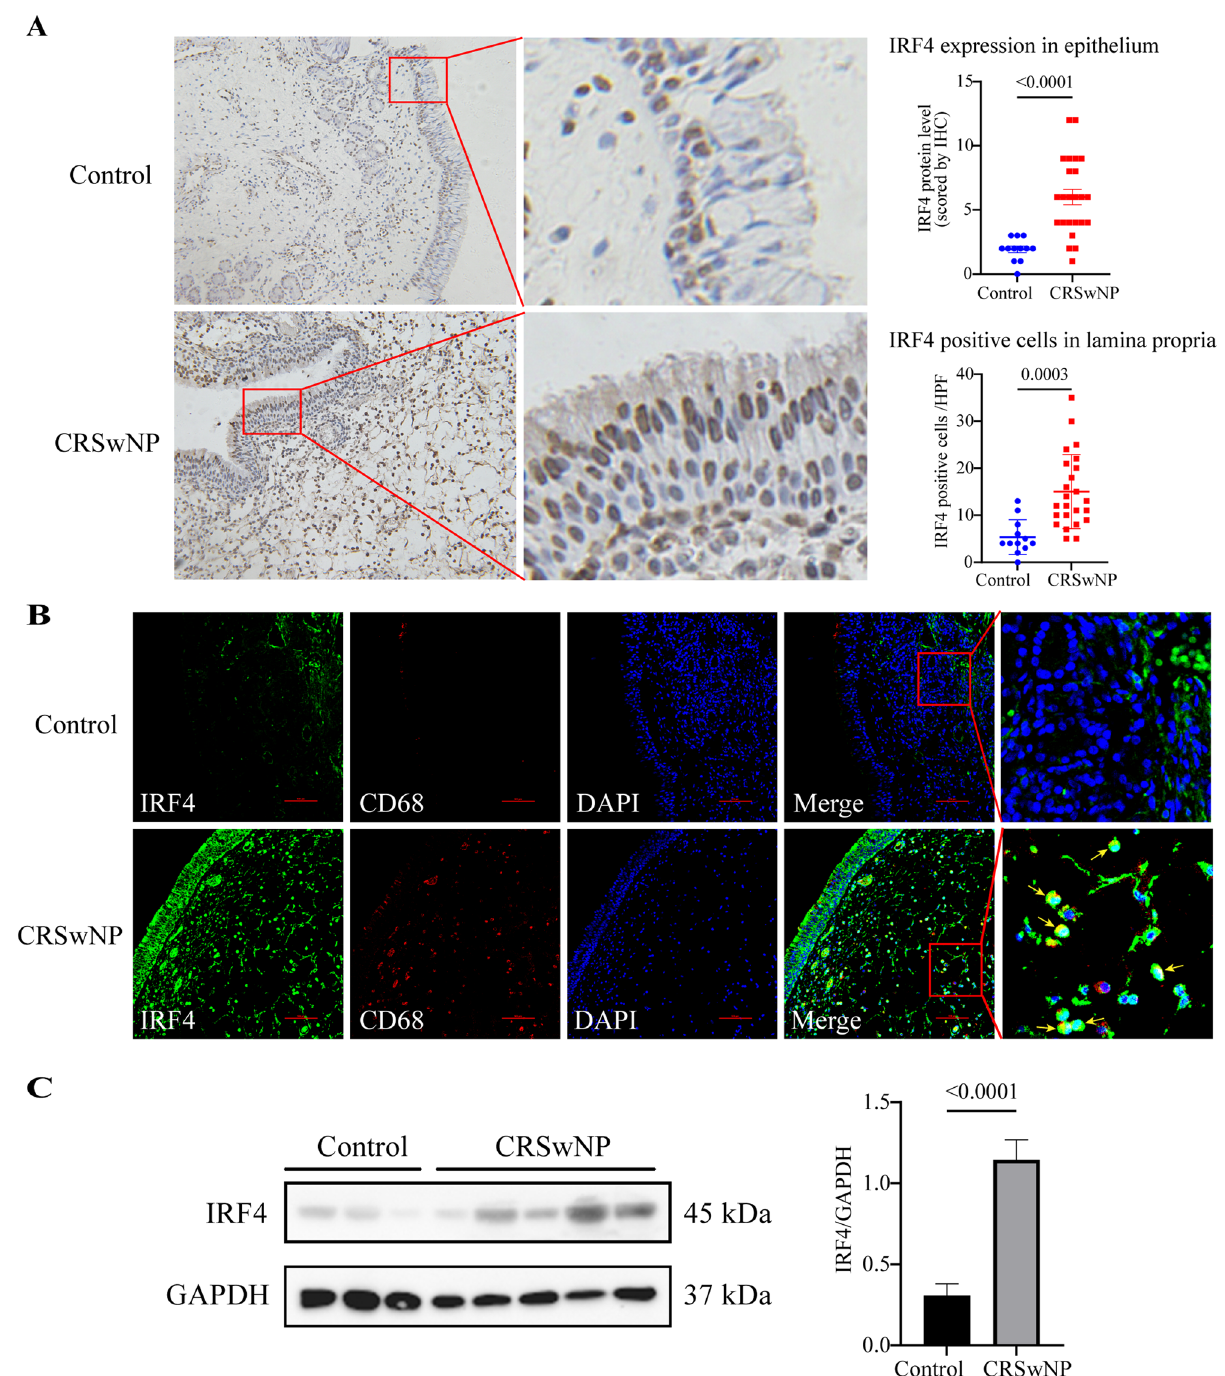
Figure 9. Experimental validation of the protein expression levels of IRF4. ( A ) Immunohistochemistry study demonstrated increased expression of IRF4 in the cytoplasm and nucleus, in nasal epithelial cells and inflammatory cells in lamina propria in nasal polyps. The representative photomicrographs are shown (original magnification × 200). ( B ) Double immunofluorescence staining demonstrated IRF4 expression in CD68 + macrophages in lamina propria in nasal polyps. Arrows denote representative positive cells. ( C ) Representative blots of IRF4 protein expression in sinonasal